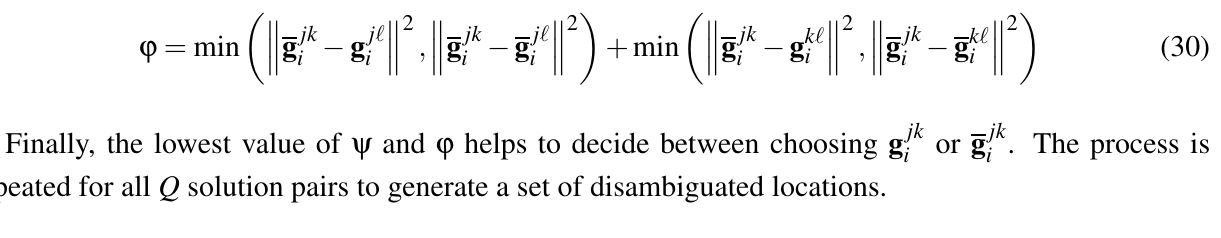
Algorithm 2 General code used by every sensor s